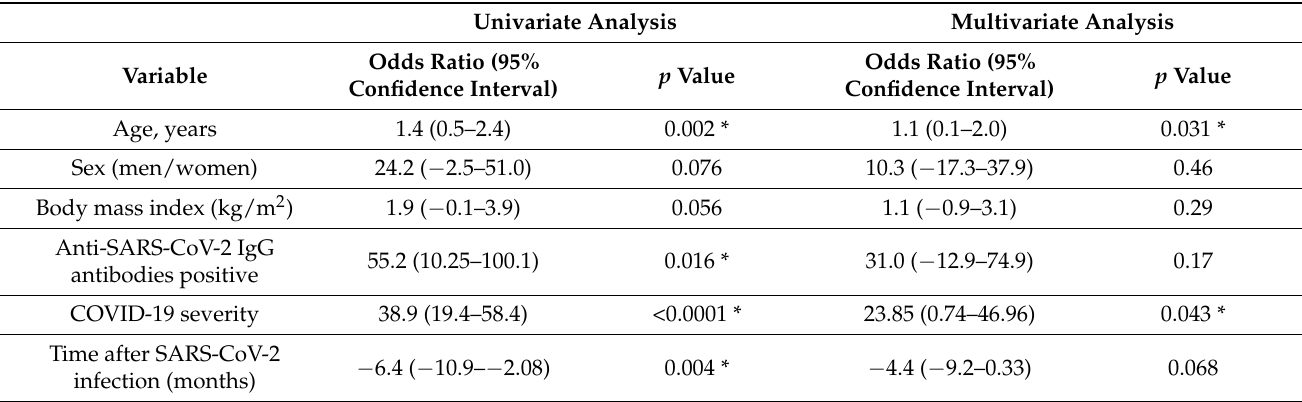
Table 3. Univariate analysis and multivariate analysis of factors associated with aggregated Spike (S) protein and Membrane (M) protein SARS-CoV-2 specific T cell response in ELISpot analysis. * significant.